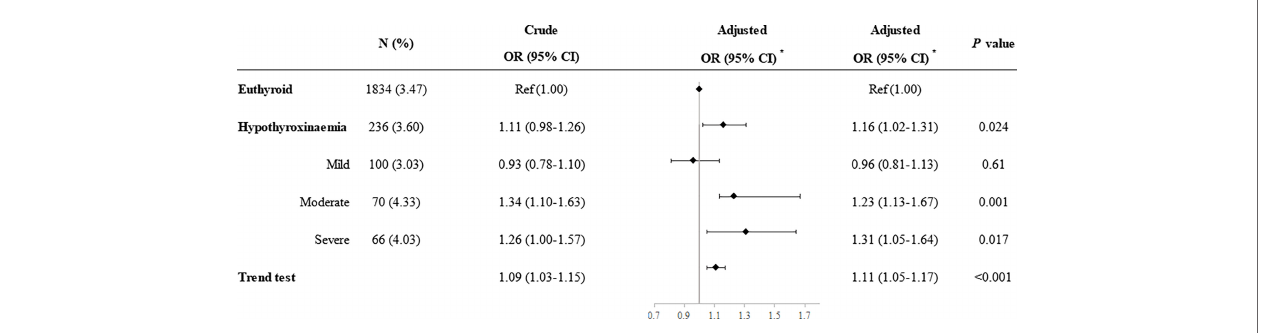
FIGURE 3 | Association of hypothyroxinemia and overall risk of preeclampsia – eclampsia. *Adjusted for parity, age, prepregnancy BMI, fetus sex, residence of origin, serum ferritin, thyrotropin level, and